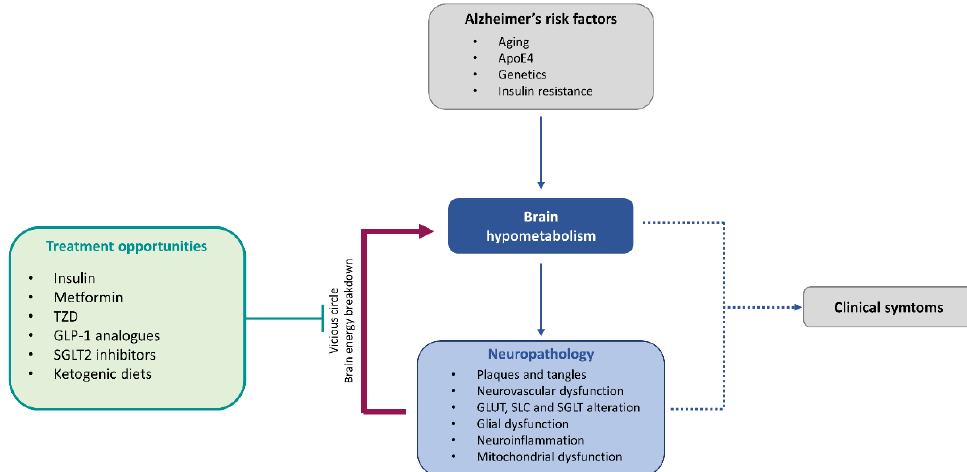
Figure 3. Central contribution of brain energy hypometabolism in Alzheimer’s disease pathology and treatment opportunities. Glucose hypometabolism occurring at early stages of the disease, together with the neuropathological features, induces a vicious cycle leading to brain energy breakdown and dysfunction. Treatment opportunities based on energy rescue strategies attempt to break this vicious circle and improve brain energy metabolism to, in last instance, prevent or revert clinical symptoms.